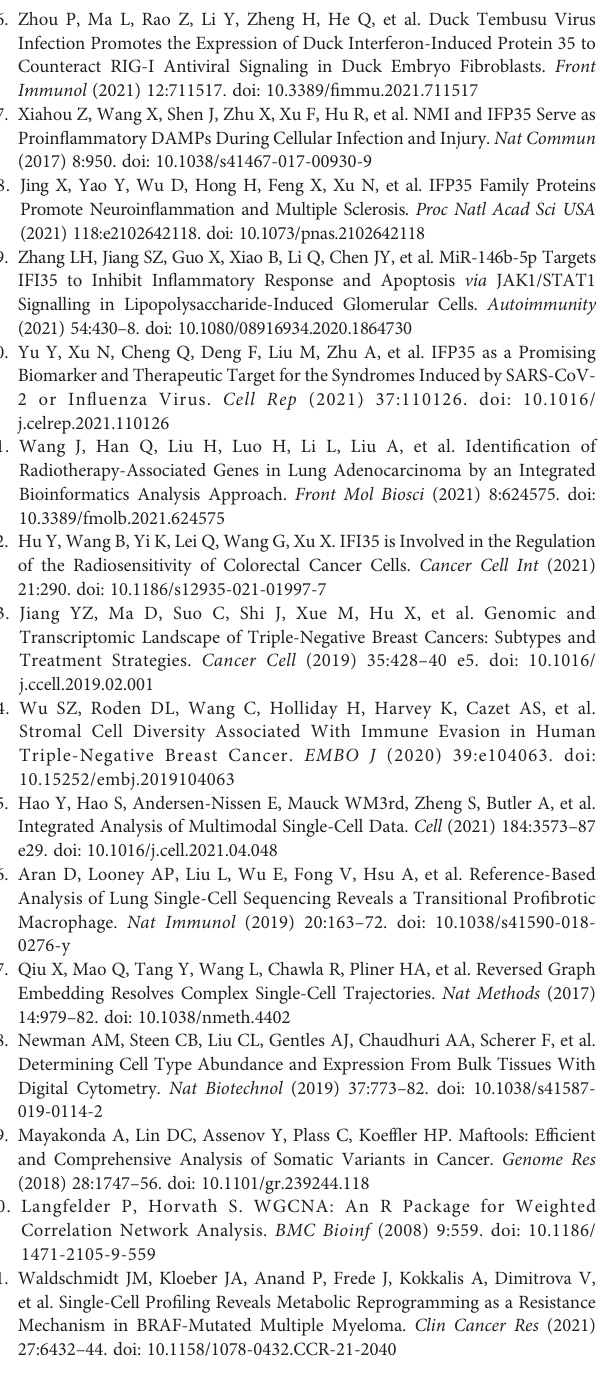
Supplementary Figure 2 | Survival analysis of immune cell subsets related to patients ’ prognosis. Cohorts, FUSCC (A) and TCGA (B) . Supplementary Figure 3 | The differentiation of mutational landscape between low and high M1 macrophage in fi ltration groups from TCGA cohort. (A, B) , Top20 mutational genes in M1macrophage low and high in fi ltration population. (C, D) , The overlap of mutations in two groups. (E) , Different mutations between two groups. (F, G) , Mutually exclusive or co-occurring mutation in two groups were explored